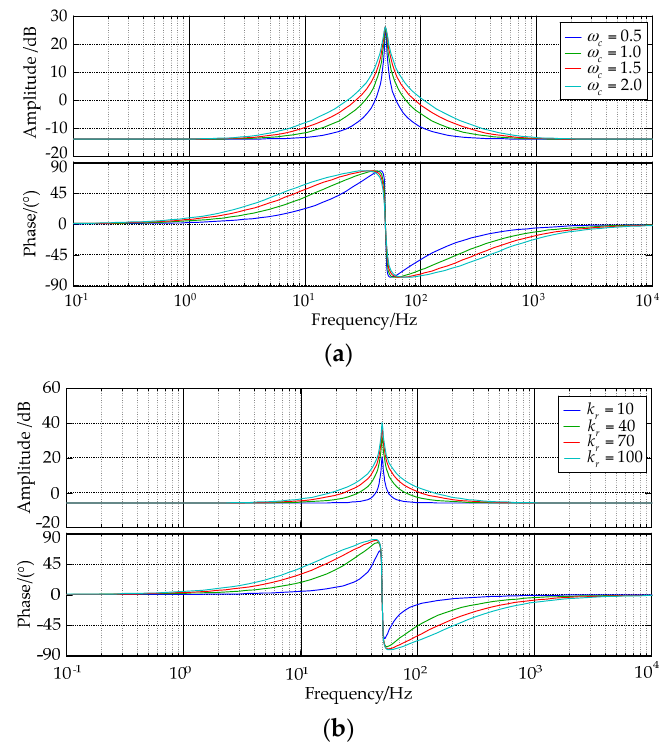
Figure 8. Bode diagram of the improved PR controller with parameters varying: ( a ) k p = 20, k r = 20, the bode diagram of different ω c ; ( b ) k p = 20, ω c = 0.5, the bode diagram of different k r .